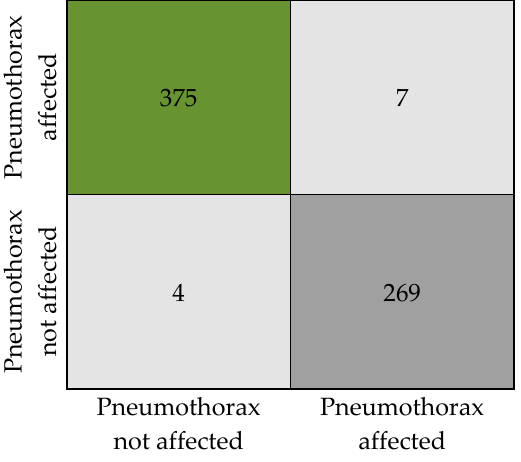
Figure 7. Confusion matrix.